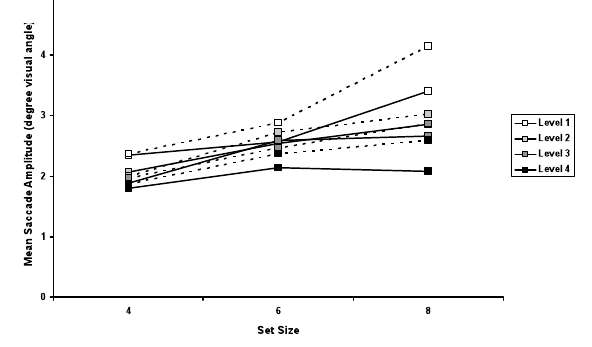
Figure 7. Mean (n = 5) saccade amplitude in the four levels of similarity and for target-present trials and target- absent trials (dotted lines) with increasing set